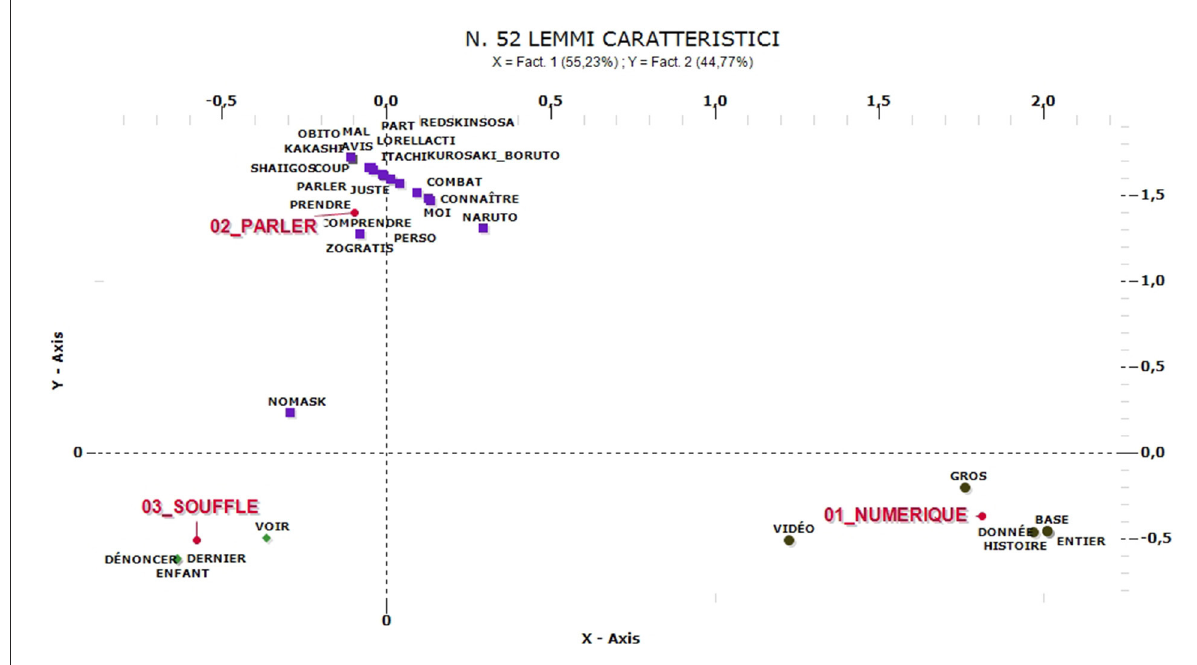
FIGURE10 ACM—“No-mask” comments in French (52 characteristic lemmas).